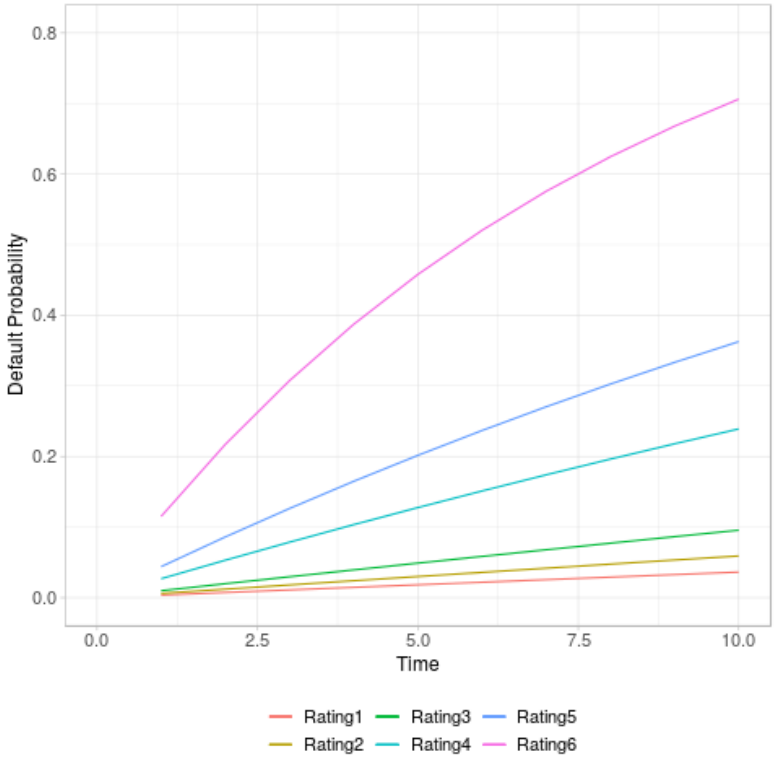
Figure 1. Term-structure of default probabilities for each rating grade.